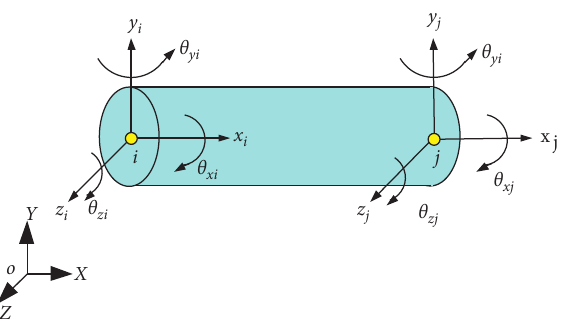
Figure 3: Rotating beam